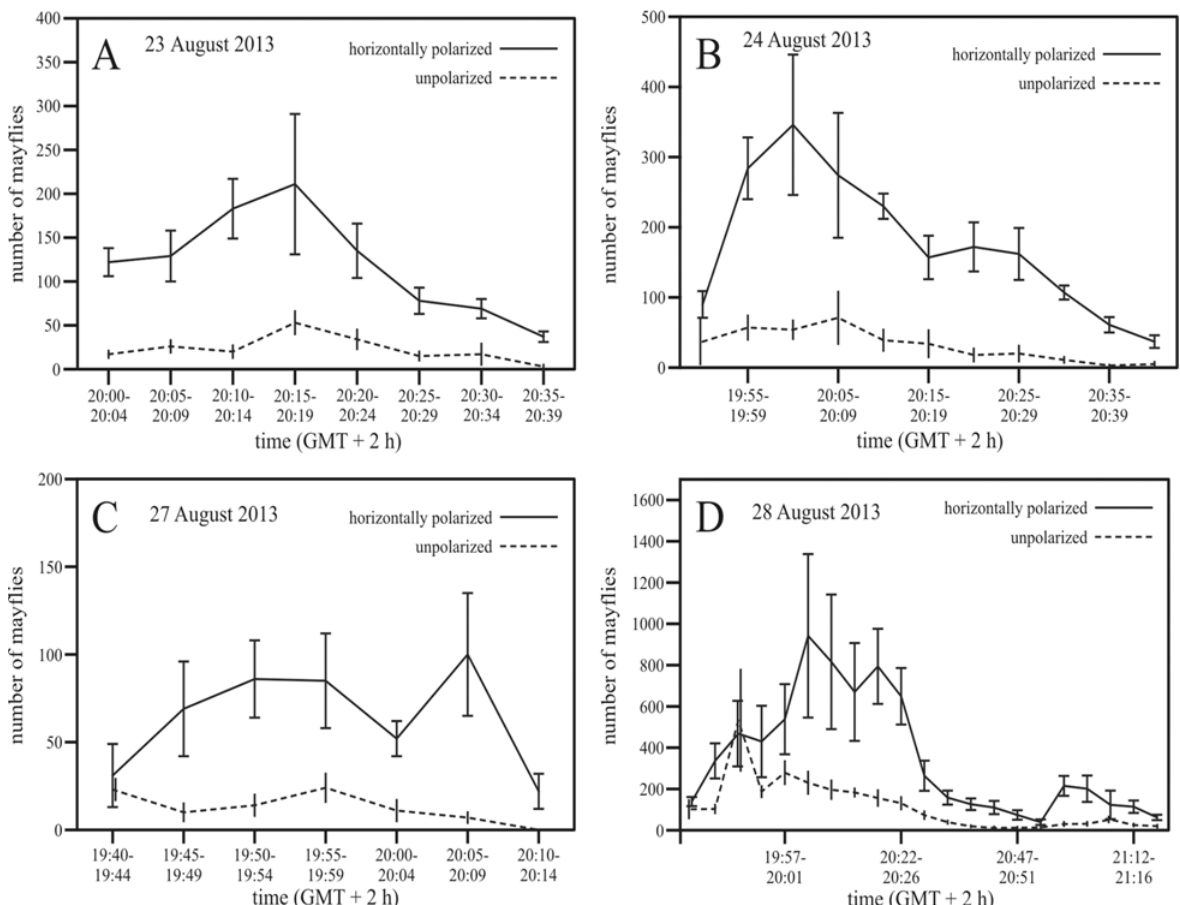
Fig 4. Estimated numbers of Ephoron virgo mayflies attracted to polarized and unpolarized light sources placed above the Danube river on four dates in 2012. Number (mean ± standard deviation) of mayflies attracted to horizontally polarized (continuous line) and unpolarized (dashed line) light as a function of time (= local summer time = GMT + 2 hours, where GMT = Greenwich Mean Time). Each estimate is based on 10 photographs (see subsection Experiments with linear polarizers of the Materials and Methods). Comparisons of total detections over the course of each test indicate that more individuals were attracted to polarized versus unpolarized light sources of the same intensity: (A) 23 August, N = 11582, U = 181, Z = 10.302, p < 0.00001; (B) 24 August, N = 22786, U = 674.5, Z = 11.388, p < 0.00001; (C) 27 August, N = 5425, U = 303.5, Z = 8.945, p < 0.00001; (D) 28 August, N = 93935, U = 8682, Z = 10.465, p < 0.00001, where N is the number of total mayfly detections, U is the parameter giving the sum of ranks used in the non-parametric method, Z is the standard deviation of data for a given p, and p is the level of significancy (p < 0.05 means significant).